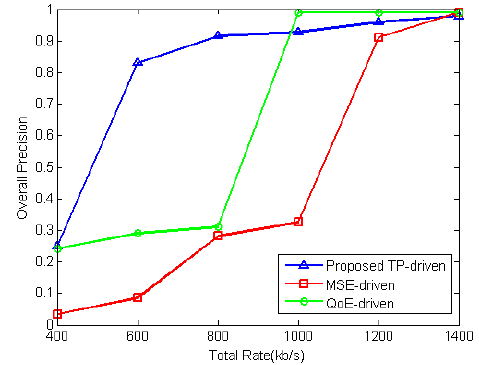
Figure 16. Product of tracking precision of each video under different total rate constraints. The packet loss rates of Tunnel and Car1(1) are 3%, and packet loss rates of other videos are 1%.